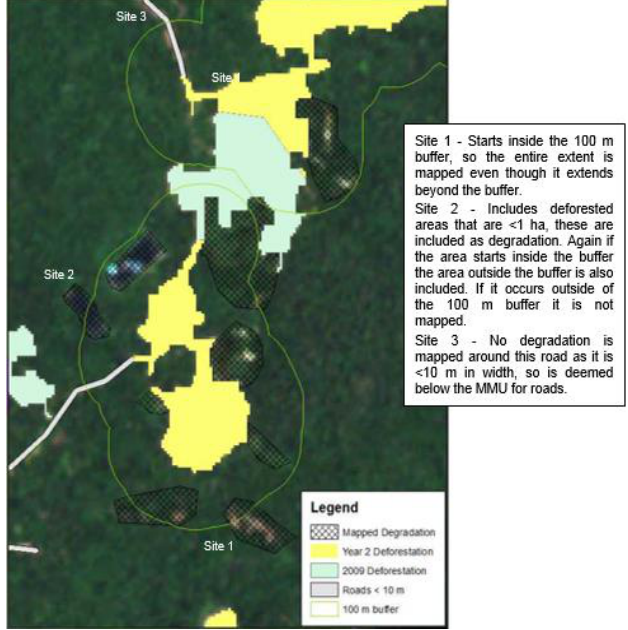
Figure 5: Change mapping © The Guyana Forestry Commission and Indufor